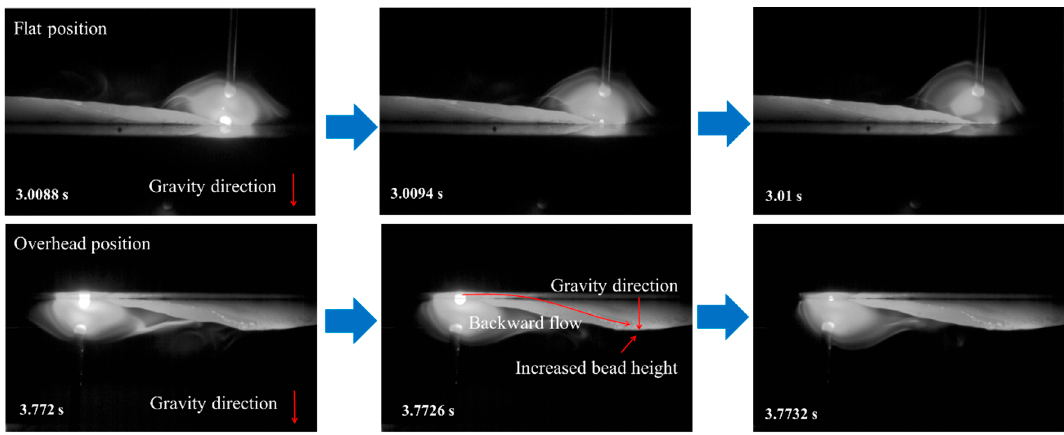
Figure 4. Synchronization of ( a ) arc images and ( b ) welding signals at a WFR of 7 m/min.